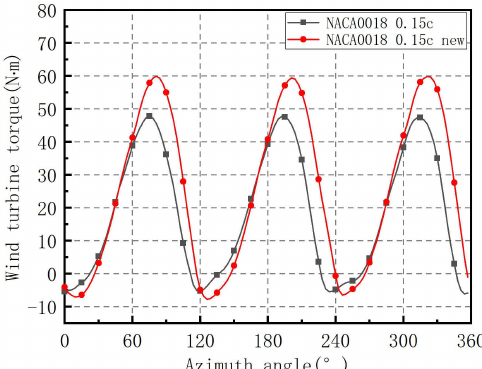
Figure 33. Variation curve of instantaneous torque with azimuth before and after optimization.